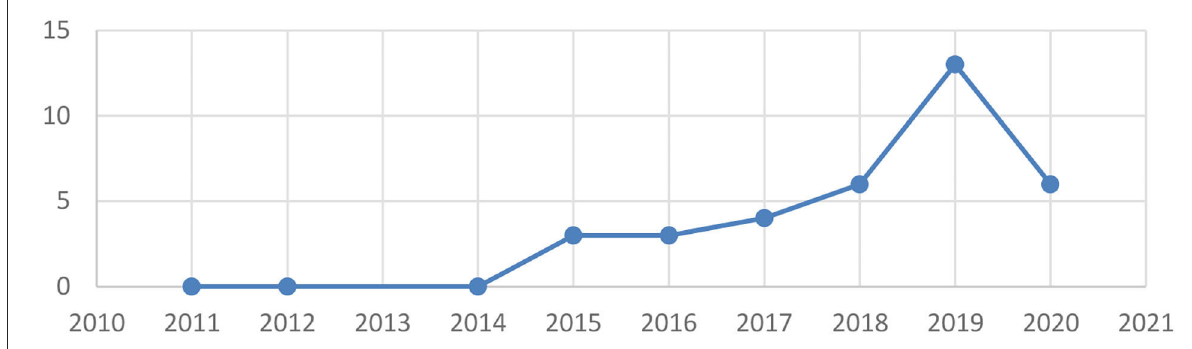
FIGURE3 Evolution over years of the samples used in the studies from 2010 to 2021.